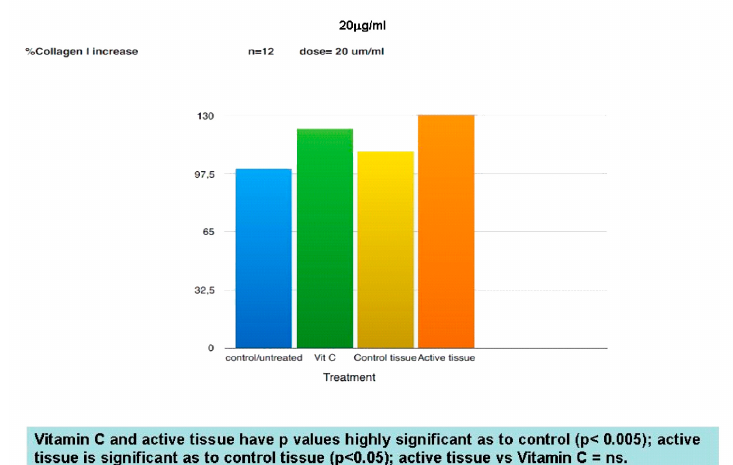
Figure 6. Anti-aging effectiveness of the mask verified by the increased production of collagen-1.